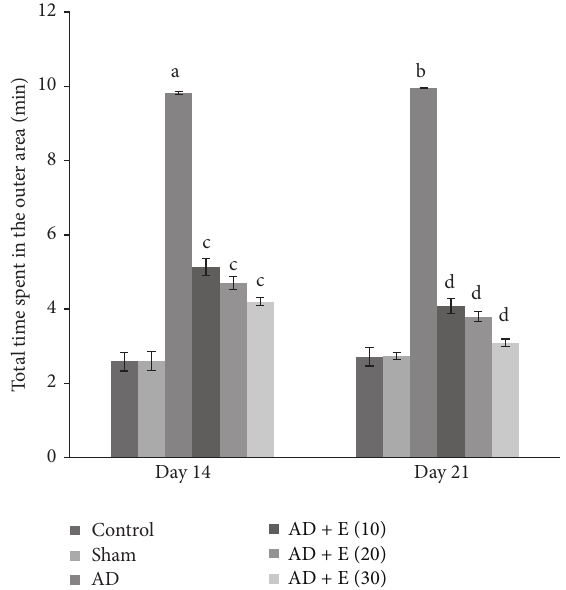
Figure 3: The total time spent in the outer area in an elevated open space with a novel object (for anxiety status) of different experimentalgroupsofrats. a cADversuscontrol/shamoperatedrats at day 14 ( 𝑝 < 0.001 ), b cAD versus control/sham operated rats at day 21 ( 𝑝 < 0.001 ), c cAD versus etoricoxib treated cAD at all the doses at day 14 ( 𝑝 < 0.001 ), and d cAD versus etoricoxib treated cAD at all the doses at day 21 ( 𝑝 < 0.001 ). Abbreviations are the same as in Figure 1. Values are expressed in mean ± SEM ( 𝑛 = 6 in each group).